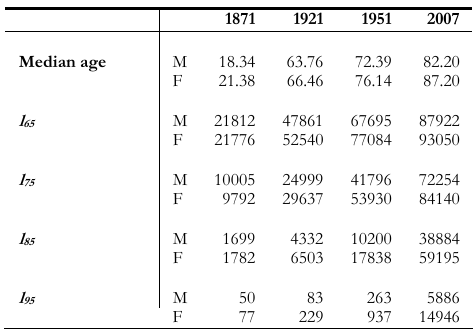
Median age at death and survivors at 65, 75, 85, 95 years by gender 1871 1921 1951 2007 Median